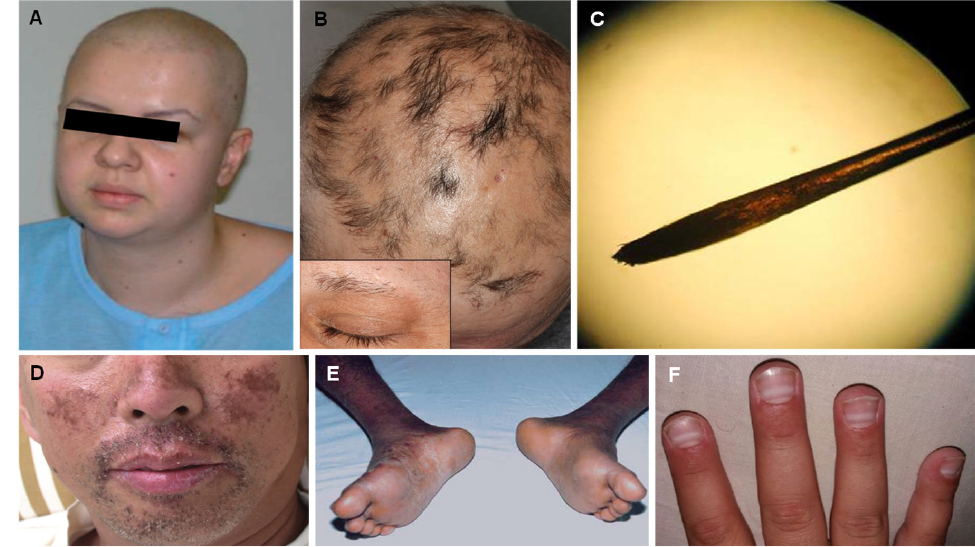
Figure 1. Characteristic scalp hair loss ( A , B ), blackened hair root under light microscopy ( C ), acne- form pustular lesions, lip oedema, and angular stomatitis ( D ), keratosis of soles ( E ), and Mee’s lines ( F ). Reprinted from ( A )—[28], ( B )—[38], ( C )—[1], ( D )—[36], ( E )—[39], ( F )—[40].